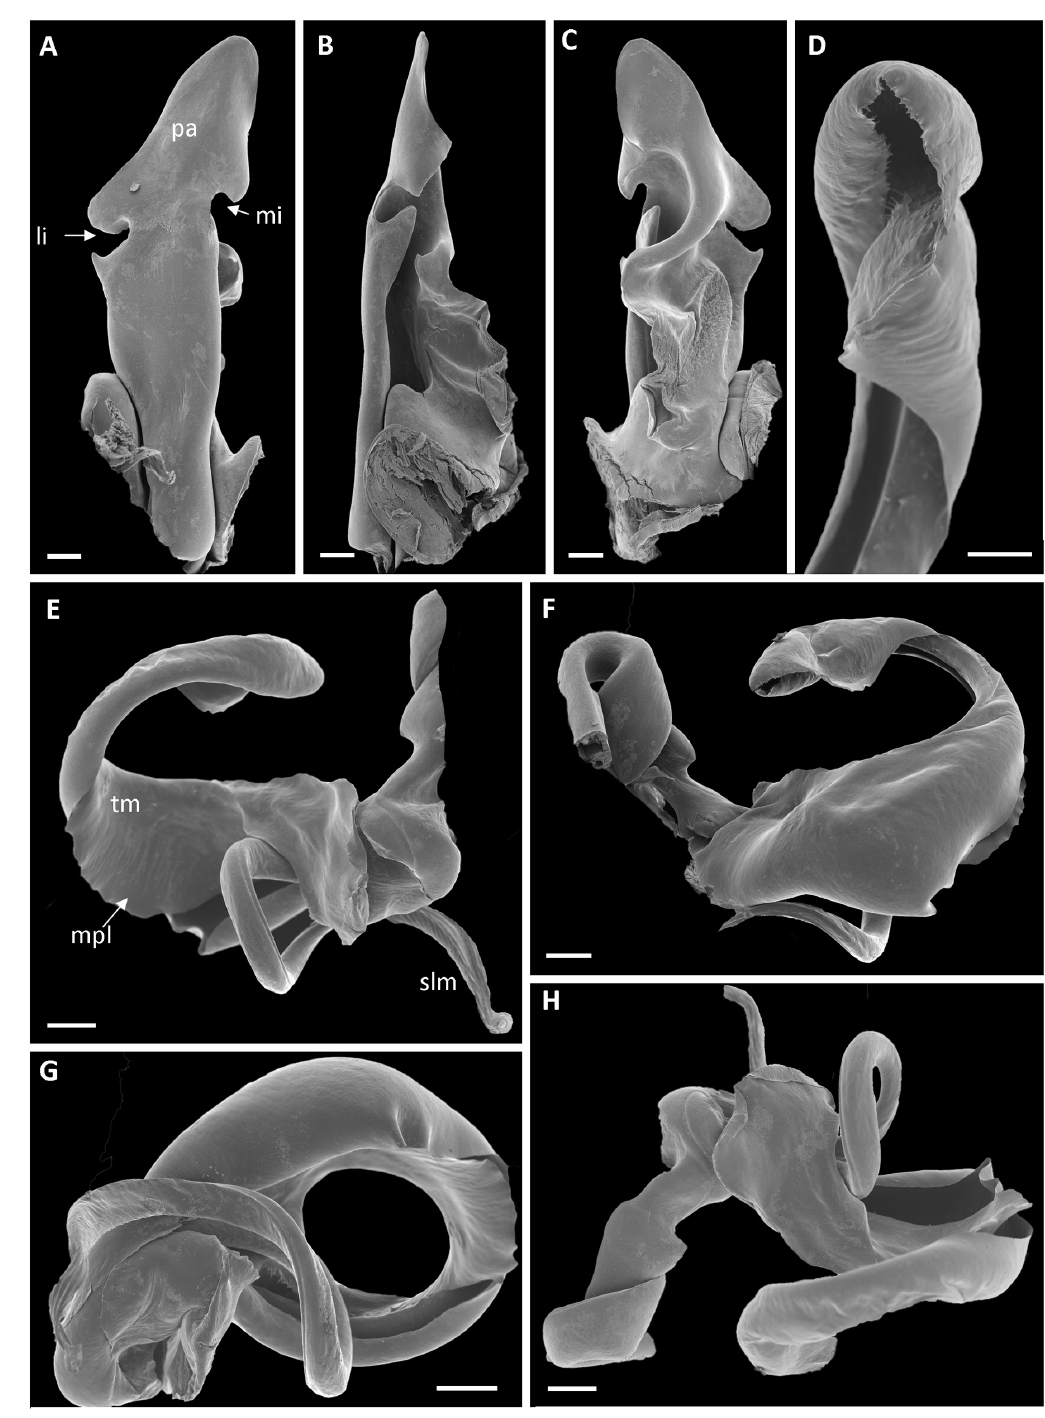
Fig. 11. Aquattuor longipala Enghoff, 2015, male, specimen from Udzungwa Mts National Park, Mito Mitatu (NHMD 621642), left gonopod. A – C . Coxa. A . Anterior view. B . Mesal view. C . Posterior view. D – H . Telopodite. D . Tip of telomere. E . Posterior view. F . Anterior view. G . Posterior-ventral view. H . Distal (ventral) view. Abbreviations: li = lateral incision; mi = mesal incision; mpl = mesal-posterior telomeral lamella; pa = palette; slm = solenomere; tm = telomere. Scale bars: A–C, E–H = 0.1 mm; D = 0.05